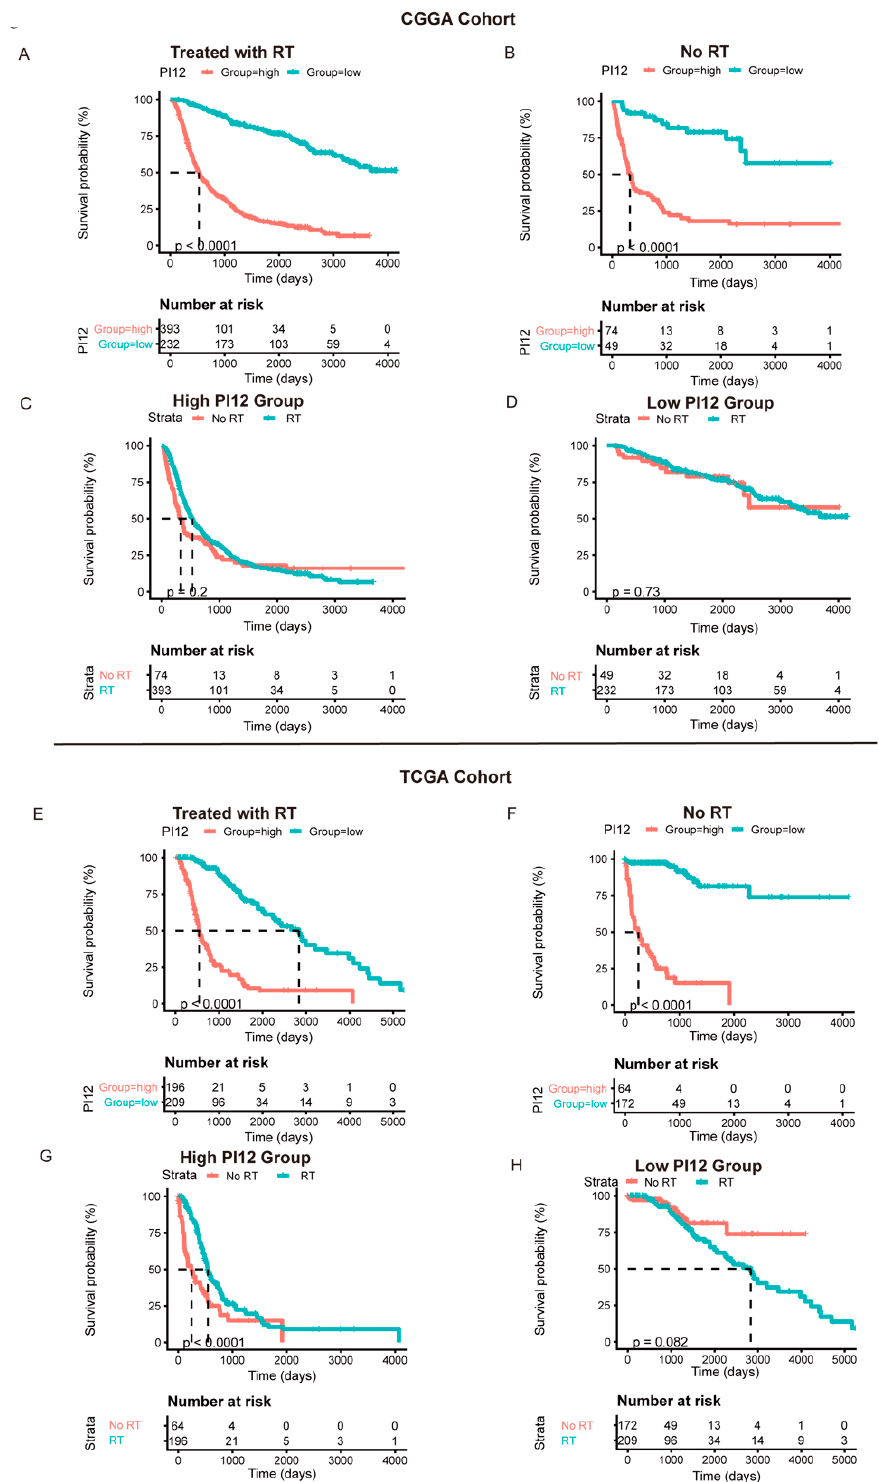
Figure 6. The prognostic value of the risk signature in CGGA cohort and TCGA cohort. ( A , E ) Kaplan–Meier survival analysis of the PI12 score for glioma patients treated with radiotherapy in CGGA cohort and TCGA cohort; ( B , F ) Kaplan–Meier survival analysis of the PI12 score for glioma patients without radiotherapy in CGGA cohort and TCGA cohort; ( C , G ) Kaplan–Meier survival analysis of radiotherapy for glioma patients in high-PI12 group in CGGA cohort and TCGA cohort; ( D , H ) Kaplan–Meier survival analysis of radiotherapy for glioma patients in low-PI12 group in CGGA cohort and TCGA cohort.